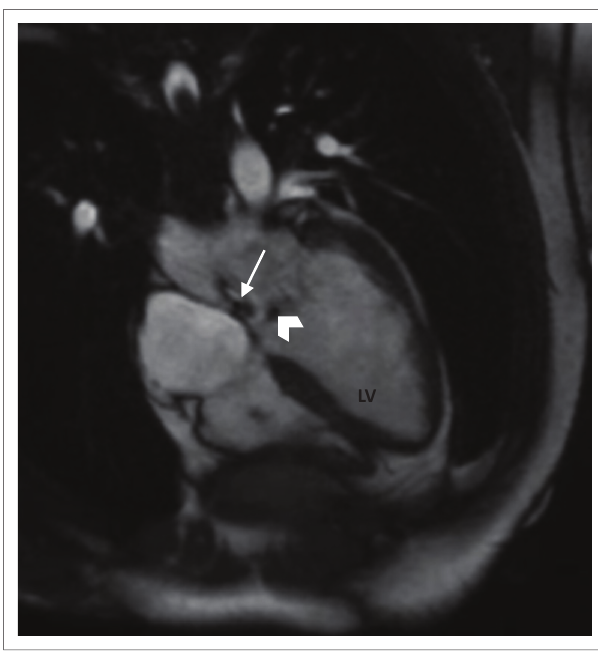
LV, left ventricle. FIGURE 8: Four-chamber SSFP cine image demonstrates an eccentric flow jet (white arrow) close to the interatrial septum arising from the aortic septum of the mitral valve (arrowhead) owing to a leaflet cleft. Cine image available at https://www.youtube.com/watch?v=eVAduRGblgU&feature=youtu.be